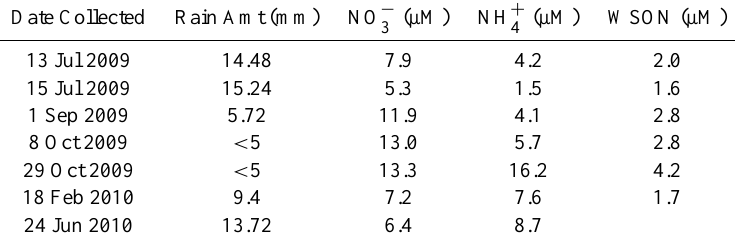
Table 1. Bulk properties of rainwater